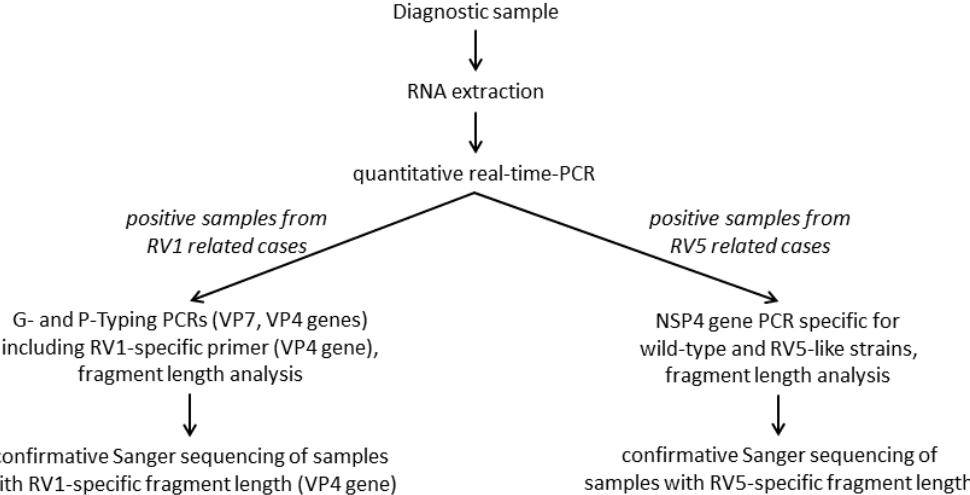
Figure 1. Workflow of the molecular differentiation of wild-type RVA and vaccine-like strains from RV1 and RV5 related cases.